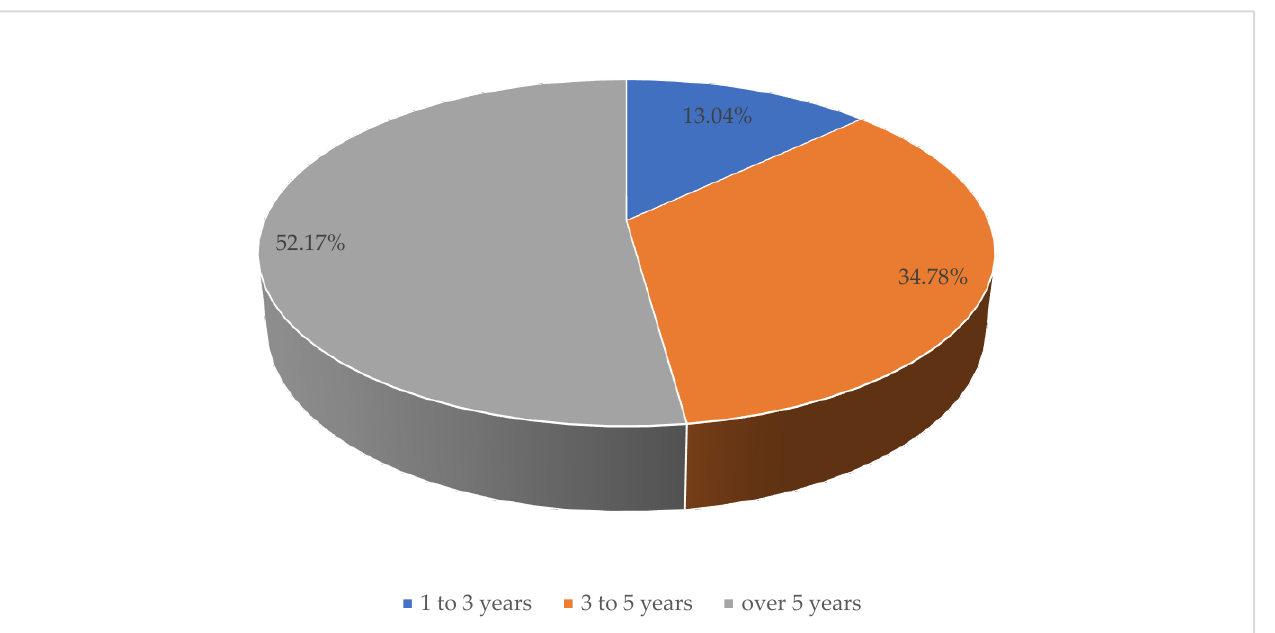
Figure 7. Experience of the participating experts, in years, on their last respective function. Source: Own study.